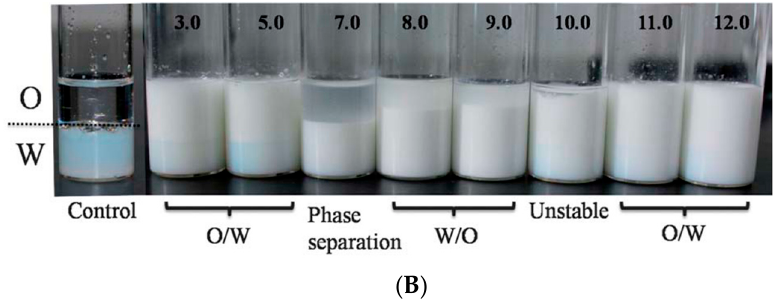
Figure 11. ( A ) Schematic illustration of the synthesis of PU-g-PDEM graft copolymers and their self-assembly in water; ( B ) The effect of solution pH on the appearance of the emulsion (1:1 water/styrene) after standing for 24 h at 25 °C. Adapted with permission from [104]. Copyright 2013, Royal Society of Chemistry.